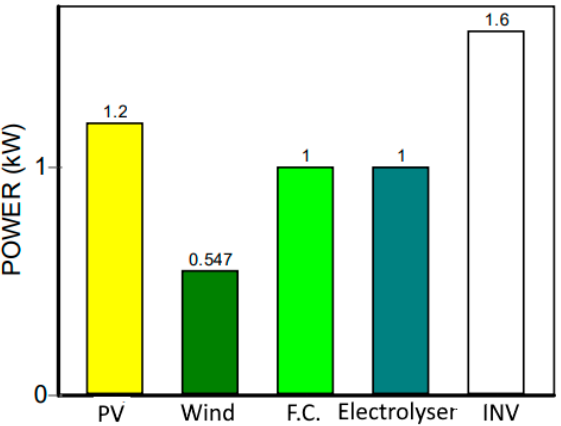
Figure 14. System components of the simulation for the second case using iHOGA.